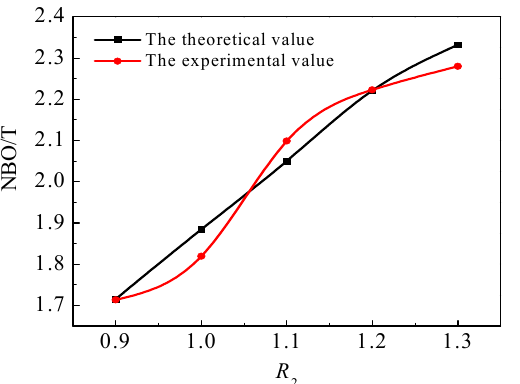
Figure 5. Theoretical and measured values of the relative content of non-bridging oxygen with different R 2 .